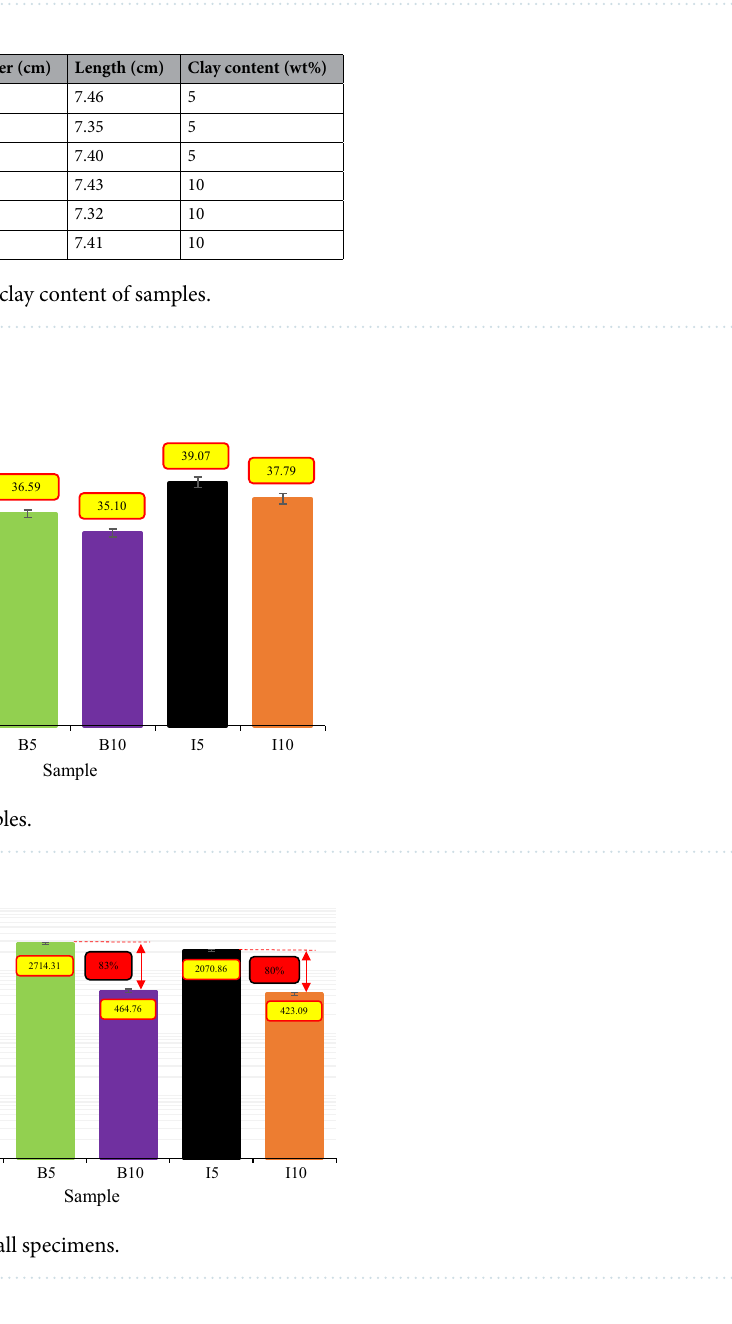
Figure 3. Dried samples in the oven.